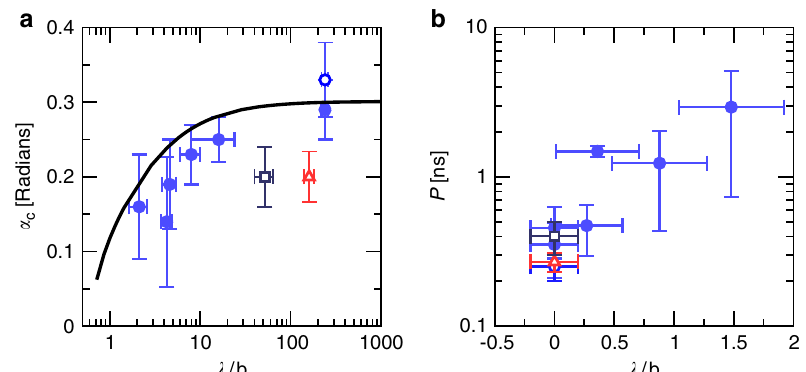
Fig. 8 Impact of the slip length on the platelet dynamics. a Average angle α c as a function of λ / b for a monolayer graphene platelet a = 1.7 nm. Data corresponds to pure graphene in water (open disk), pure graphene in NMP (open square), pure graphene in CPO (open triangle) and surface-modi fi ed graphene in water (full disks). Error bars on both α c and λ correspond to standard deviations in MD measurements. b Average time period P of the orbit, as a function of λ / b . Data corresponds to a no-slip platelet in water (open disk), no-slip platelet in NMP (open square), no-slip platelet in CPO (open triangle) and surface-modi fi ed graphene in water (full disks). Error bars on P are the standard deviation measured on